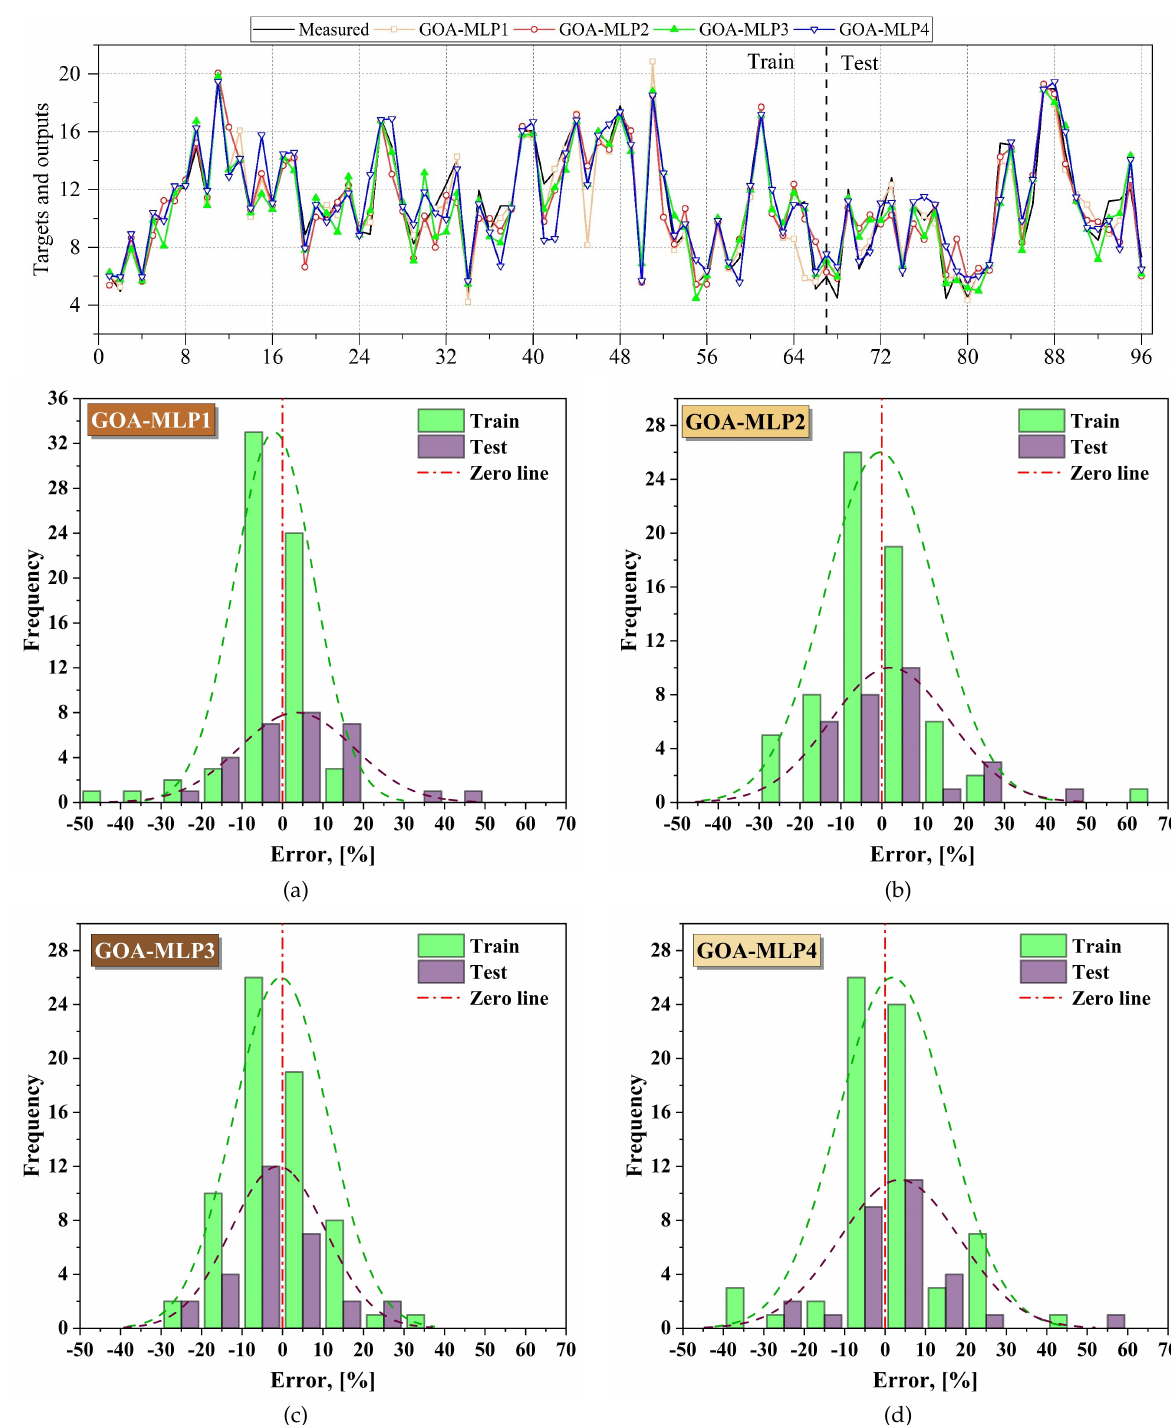
Fig. 11. Comparison between measured and predicted SP and error histogram for GOA-MLP